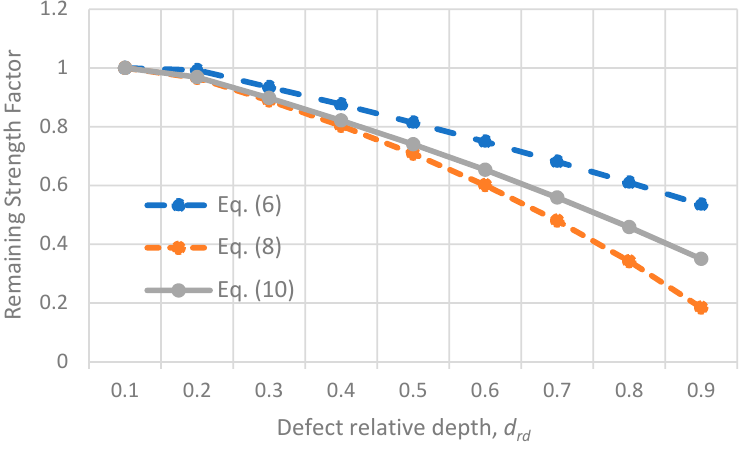
Figure 3. RSF versus relative depth of the defect, d rd.